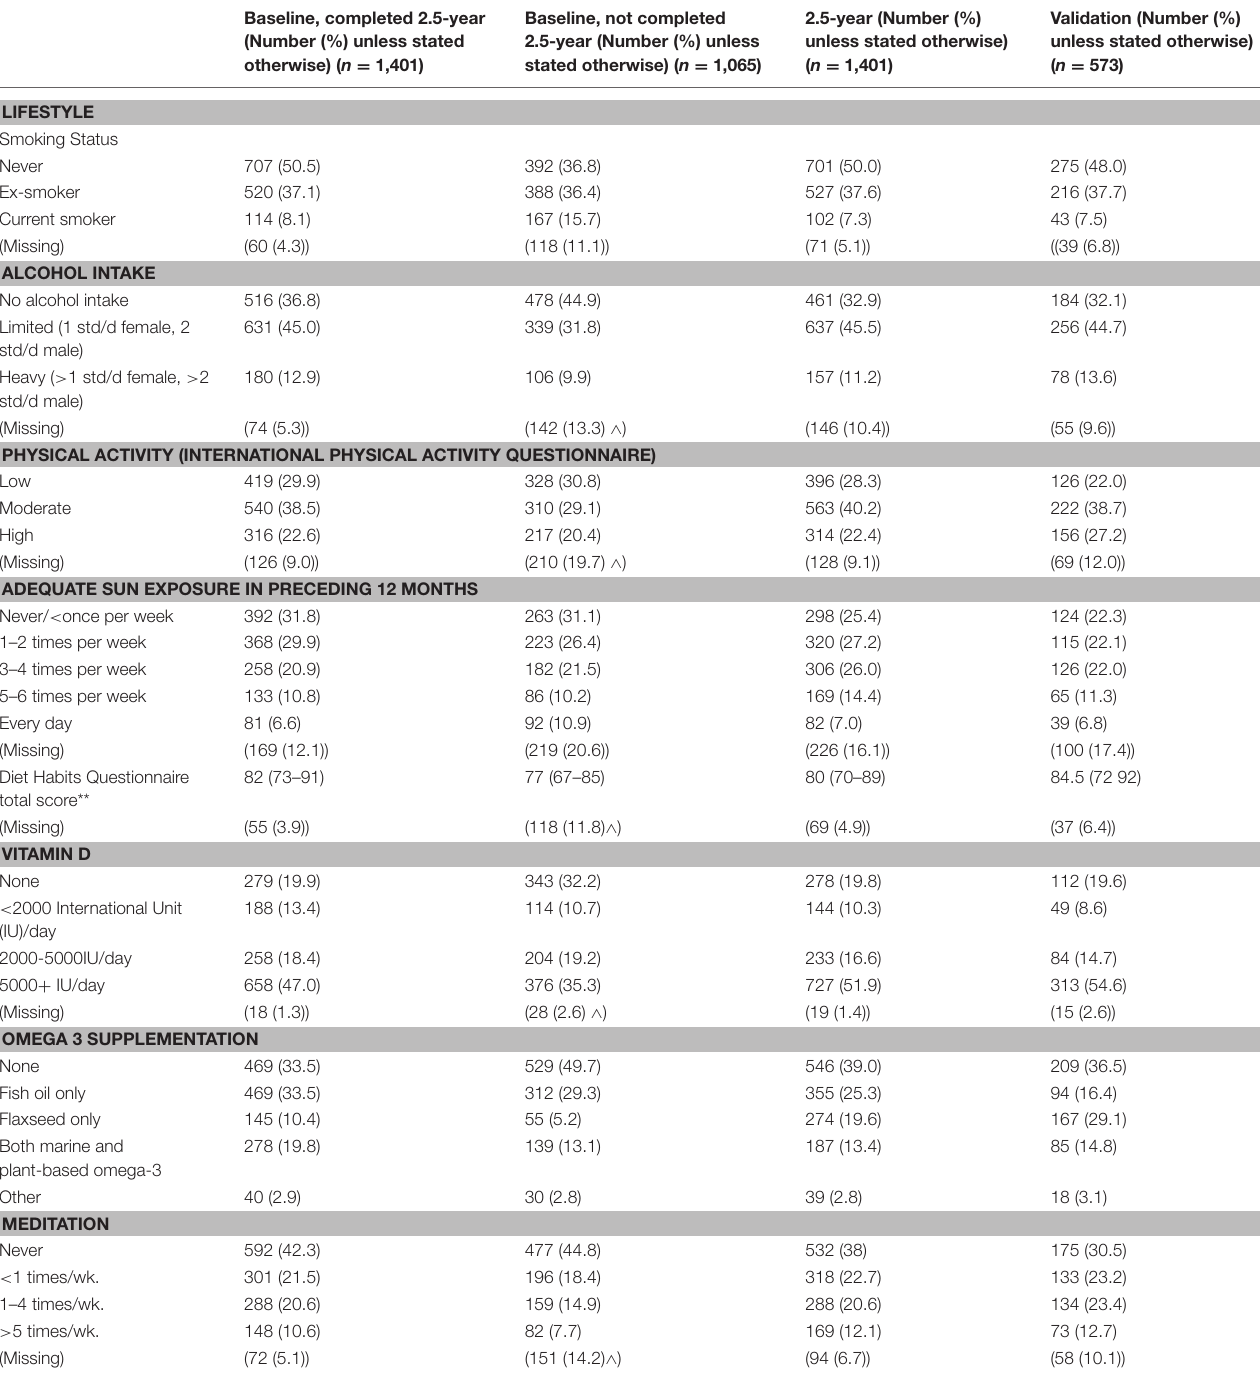
TABLE 4 | Lifestyle characteristics of the 2.5-year and validation cohorts and the baseline characteristics of the participants who completed and were lost to follow-up at 2.5-year follow-up. Baseline, completed 2.5-year (Number (%) unless